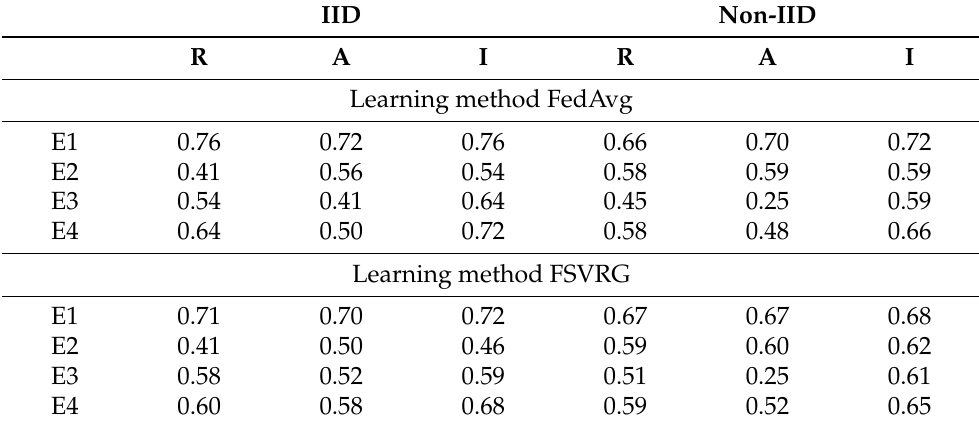
Table 7. Classification accuracies for dataset FEMNIST.